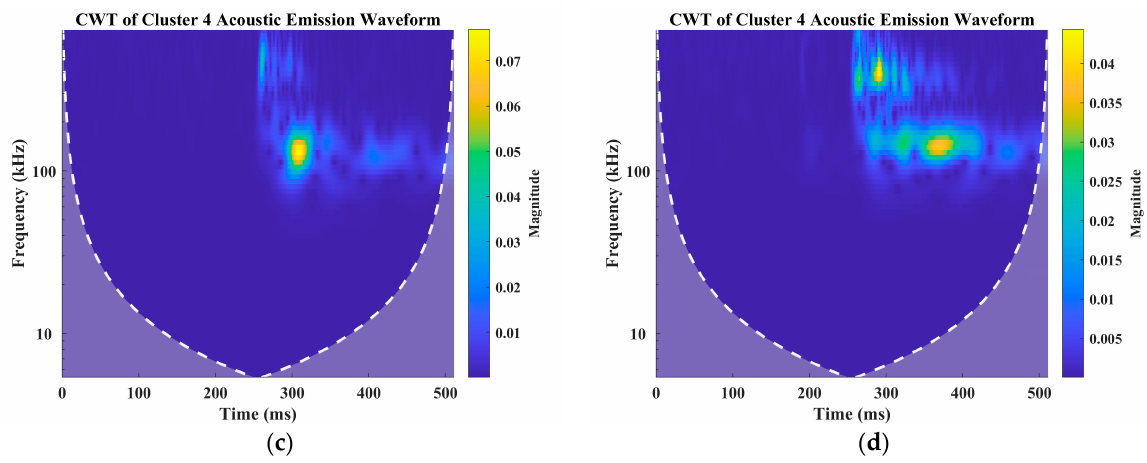
Figure A5. CWT spectrograms of four randomly selected AE signals ( a ) Signal 1; ( b ) Signal 2; ( c ) Signal 3; ( d ) Signal 4 from Cluster 4.